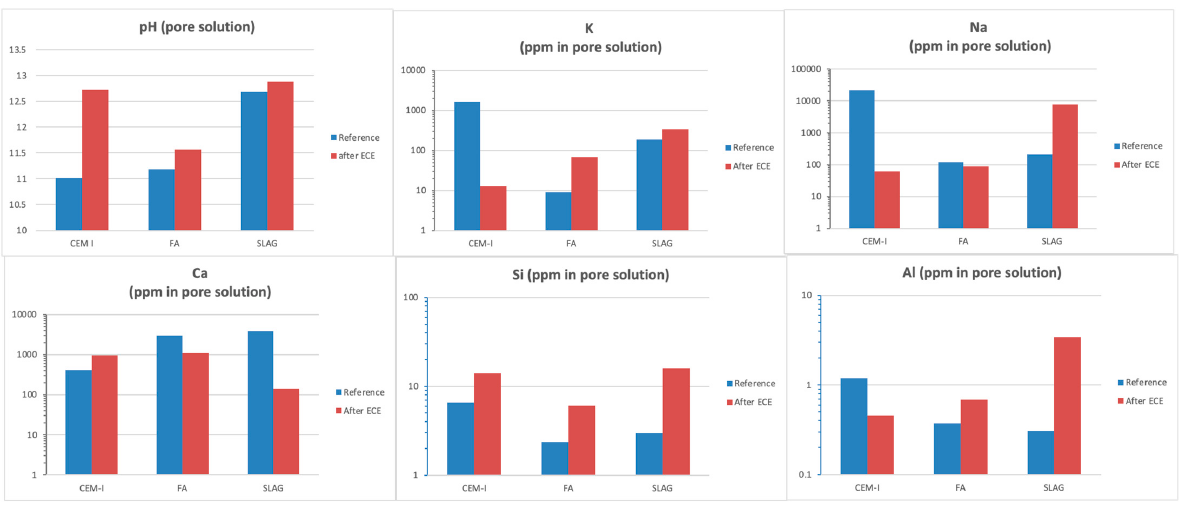
Figure 16. Influence of binder type in the pore solution before and after ECE treatment.